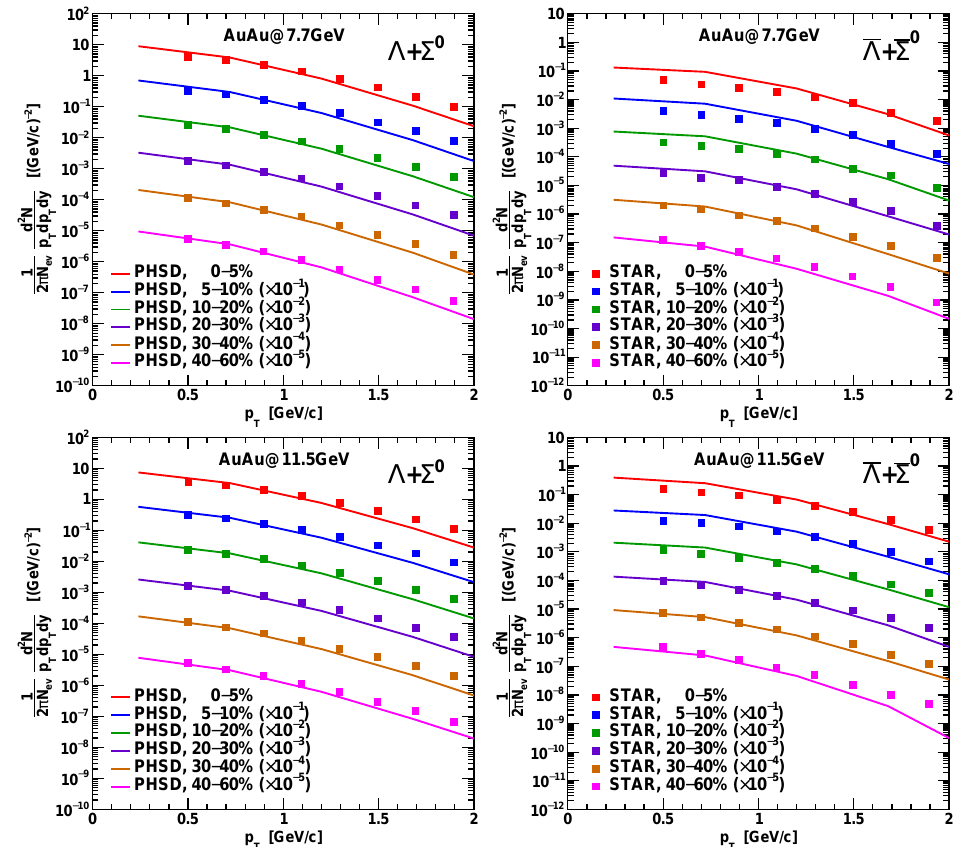
Figure 3. The transverse momentum, p T , distributions of hyperons ( Λ + Σ 0 ) ( left column ) and anti- √ s NN = 7.7GeV ( upper row ) hyperons ( Λ + Σ 0 ) ( right column ) for Au+Au collisions at energies and 11.5GeV ( lower row ) for the mid-rapidity | y | < 0.5. Calculations correspond to various centrality classes. The curves obtained for centralities higher than 0–5% are scaled down by the factors shown in Figure. Dots show the experimental result obtained by the STAR collaboration [43]. The energy density, baryon density, and temperature distributions as functions of TLI, t l.i. , for hyperons (left column) and anti-hyperons (right column) are shown in Figure 4. At earlier times (2 fm/ c < ∼ t l.i. < ∼ 4 fm/ c ) the distributions of hyperons are very broad and spread to very high values of ε ∼ 1 GeV/fm 3 , n B ∼ 20 n 0 and T ∼ 200 MeV. These distributions are due to the initial hard collisions (with string breaking) where the ‘un- formed’ hadrons are created and, then, propagate during the formation time. With some probability, they can propagate away from the fireball without further interaction after final formation. The second “hot spot” in the hyperon distributions, which is seen at times 7 fm/ c < ∼ t l.i. < ∼ 13 fm/ c , corresponds to the hyperon production mainly in hadron- scattering processes and resonance decays.